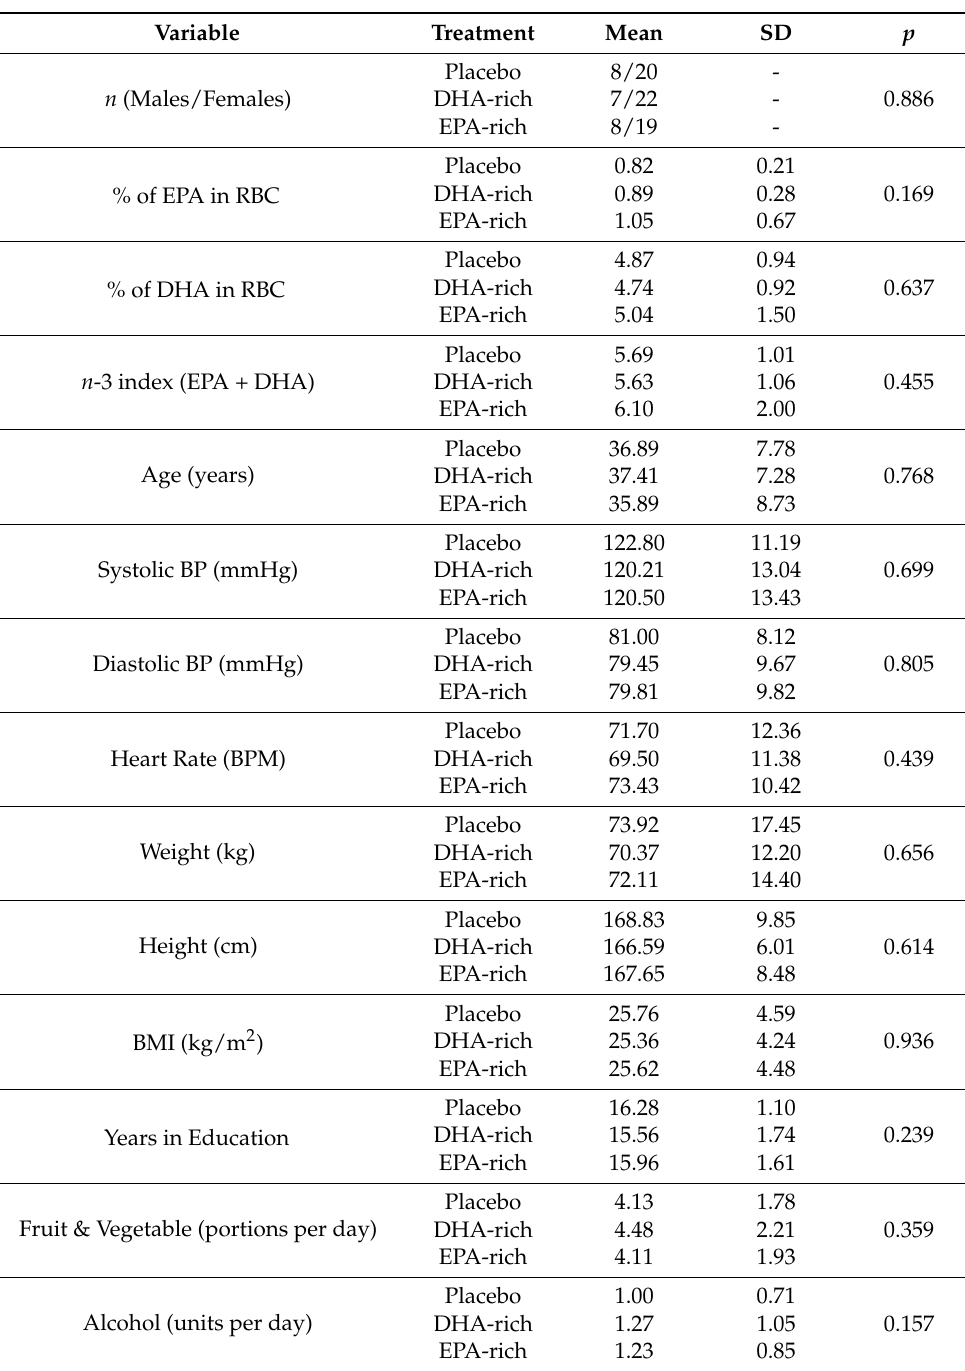
Table 1. Demographic information and baseline characteristics for the 84 participants who completed all aspects of the study. Means ± SD are given where appropriate. Baseline differences were assessed using separate one-way ANOVAs or chi-square tests; resulting p values from these analyses are